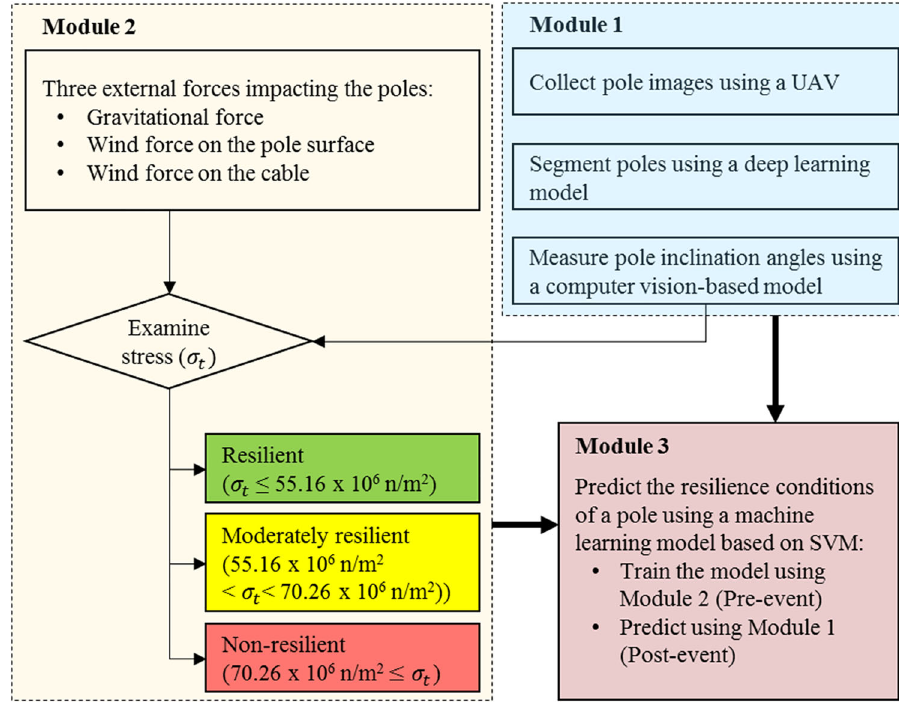
Fig. 1 The framework of the method proposed to determine the resilience of utility poles— three